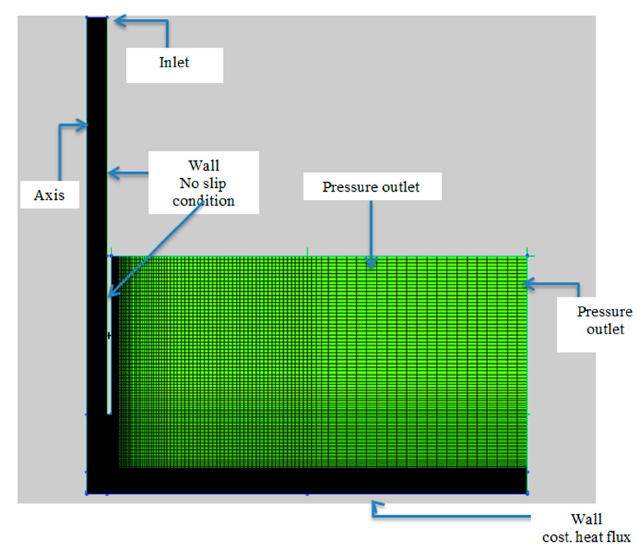
Figure 1. The 2D axisymmetric computational domain: case H / D = 2.